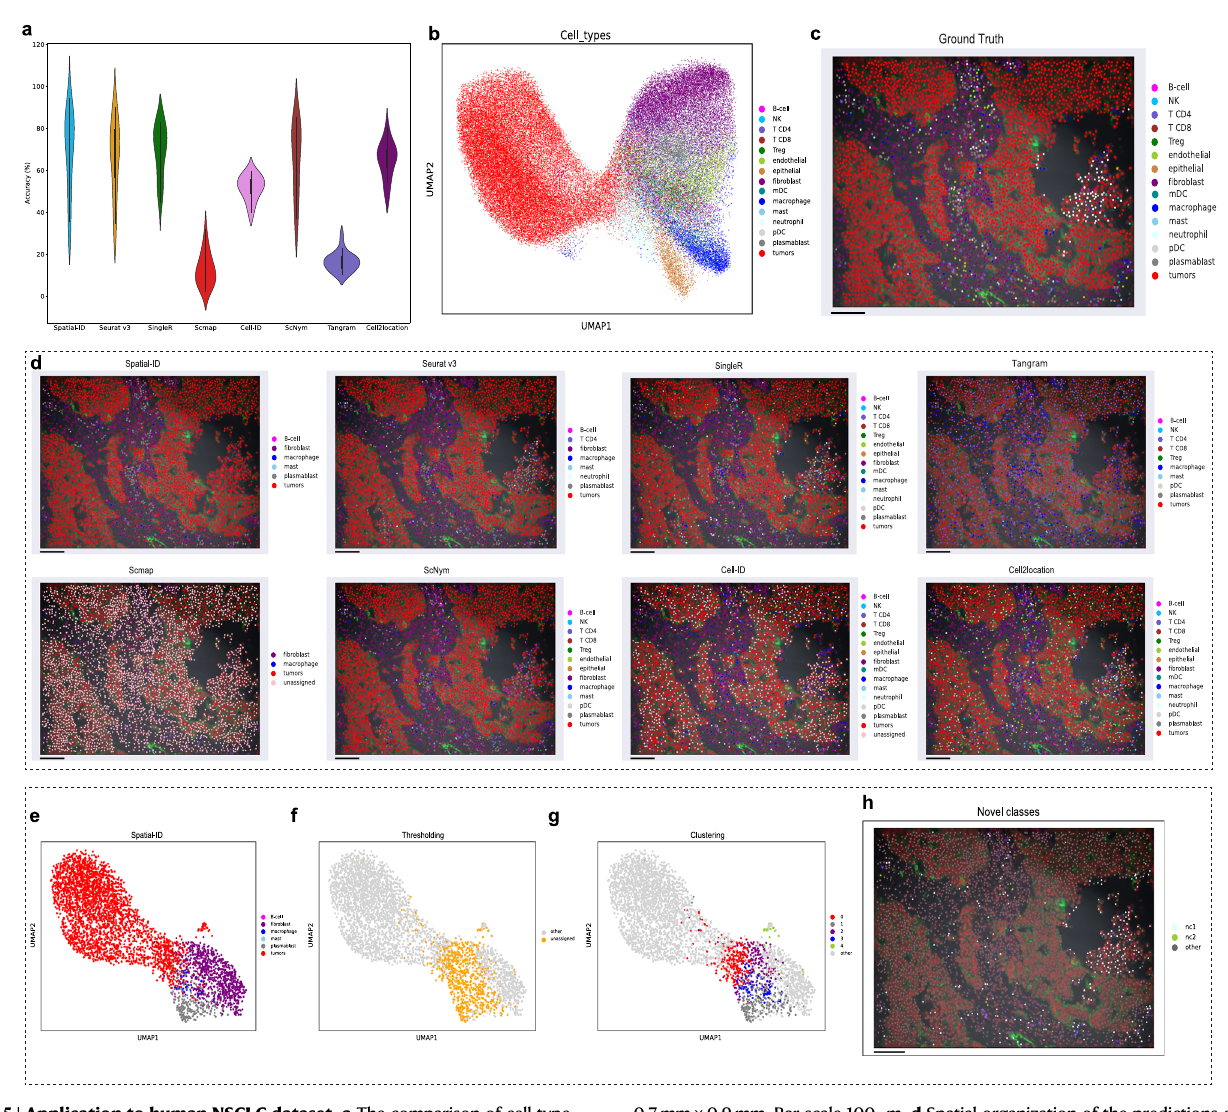
Fig. 5 | Application to human NSCLC dataset. a The comparison of cell type annotation accuracy; n =20 independent samples; Center line, median; box limits, upper and lower quartiles; whiskers, 1.5× interquartile range. Notably, the mean accuracyofSciBetis0.98%,thatisfarbelowthoseshownandisthereforenotshown. b Visualization of the ground truth cell types using UMAP embedding. c Spatial organization of the ground truth cell types of a sample. Field size is